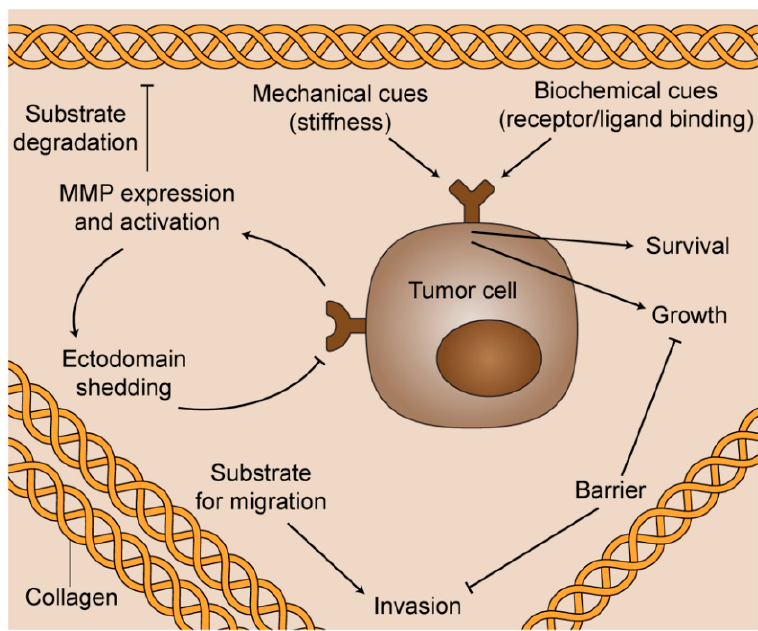
Figure 2. The multifunctional role of fibrillar collagen in cancer progression. Biochemical cues and specific organizational changes in collagen result in diverse pathological consequences for the survival, proliferation, and spread of cancerous cells.